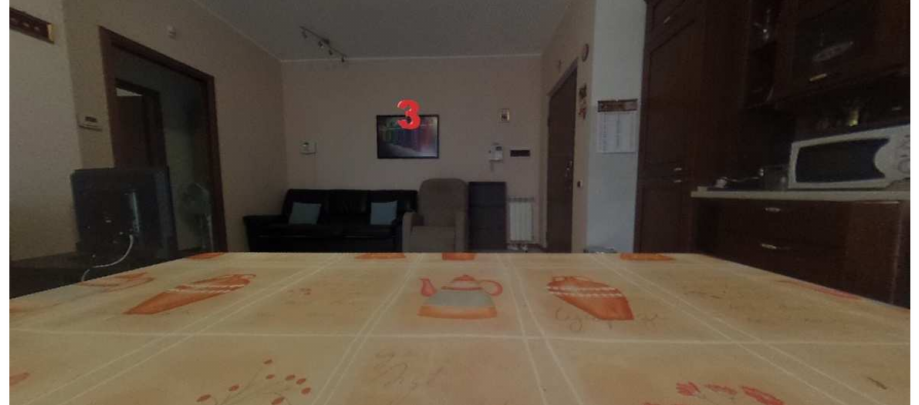
Figure 2. The representation of Task 7: the 360 ◦ kitchen showing one of the series